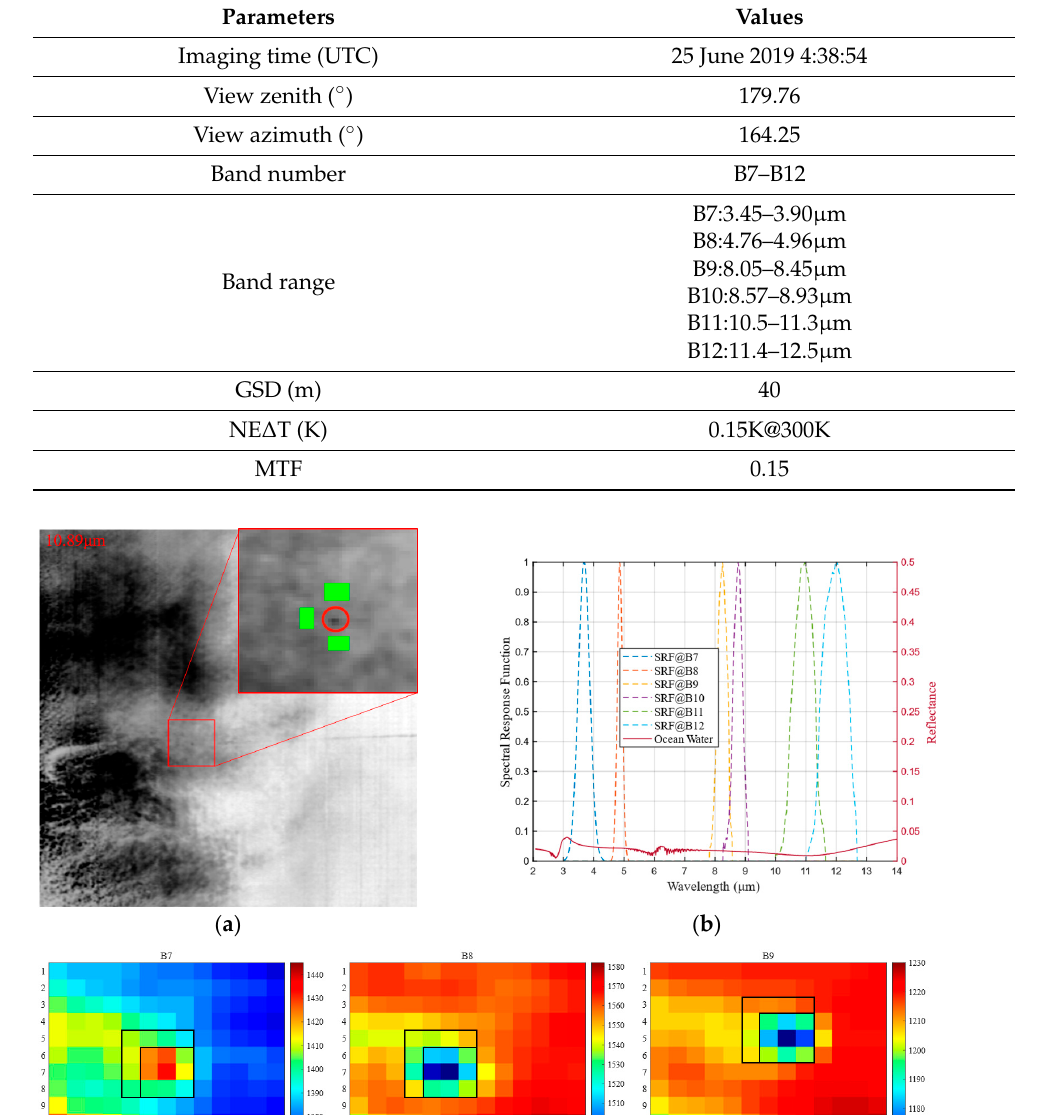
Table 1. Imaging information and instrument performance parameters of GF-5 VIMS.